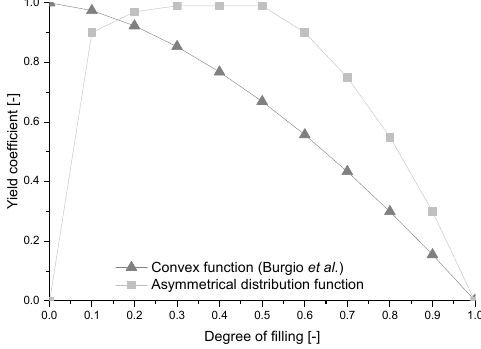
Figure A5. Yield coefficient of the process in correlation to the degree of filling